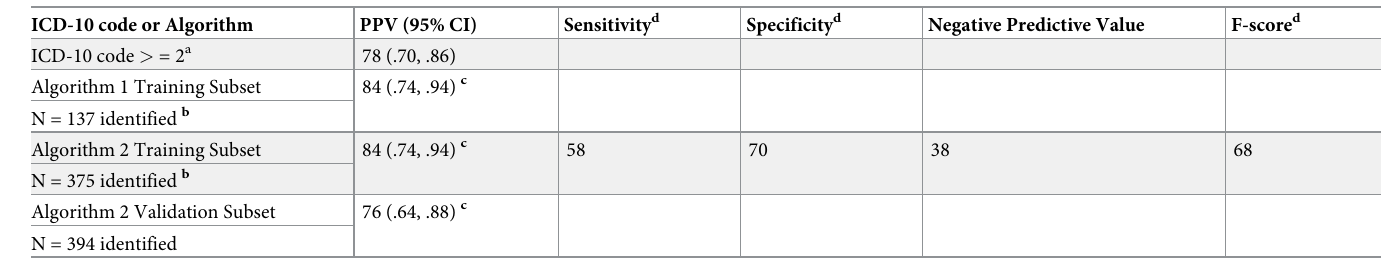
Table 3. Performance characteristics of ICD-10 code and algorithms.